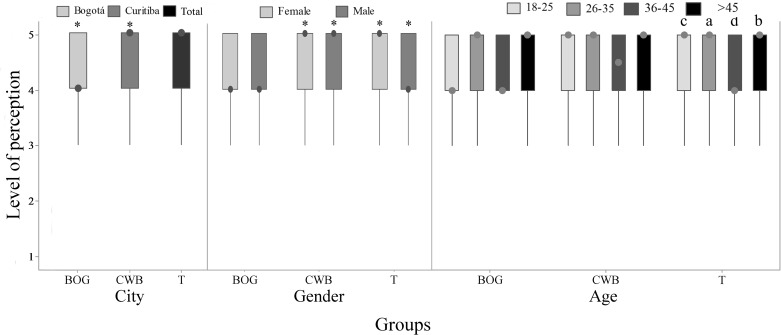
Perception of fish suffering out of water (Q3) by 782 citizens of Bogotá and Curitiba, 2014/2015.Data for city, gender and age; 1 = certainly not and 5 = certainly yes; (BOG) represents data from Bogotá, (CWB) data from Curitiba and (T) the total data; the asterisk indicates city and gender difference (P<0.05, Mann-Whitney); letters indicate differences between age groups (P<0.05, Kruskal-Wallis and Dunn Test).